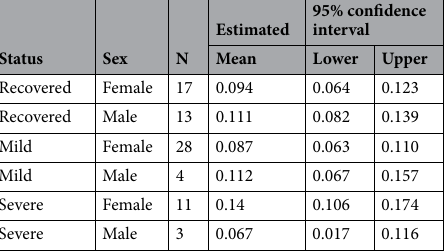
Table 5. Least square mean magnetization transfer ratio homogeneity from linear mixed model for clinical outcome groups by sex, including imputed